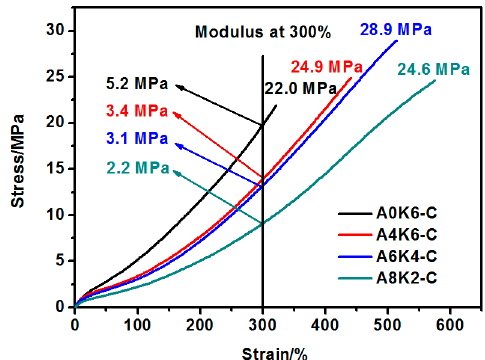
Figure 12. Mechanical performance of silica/NR composites.